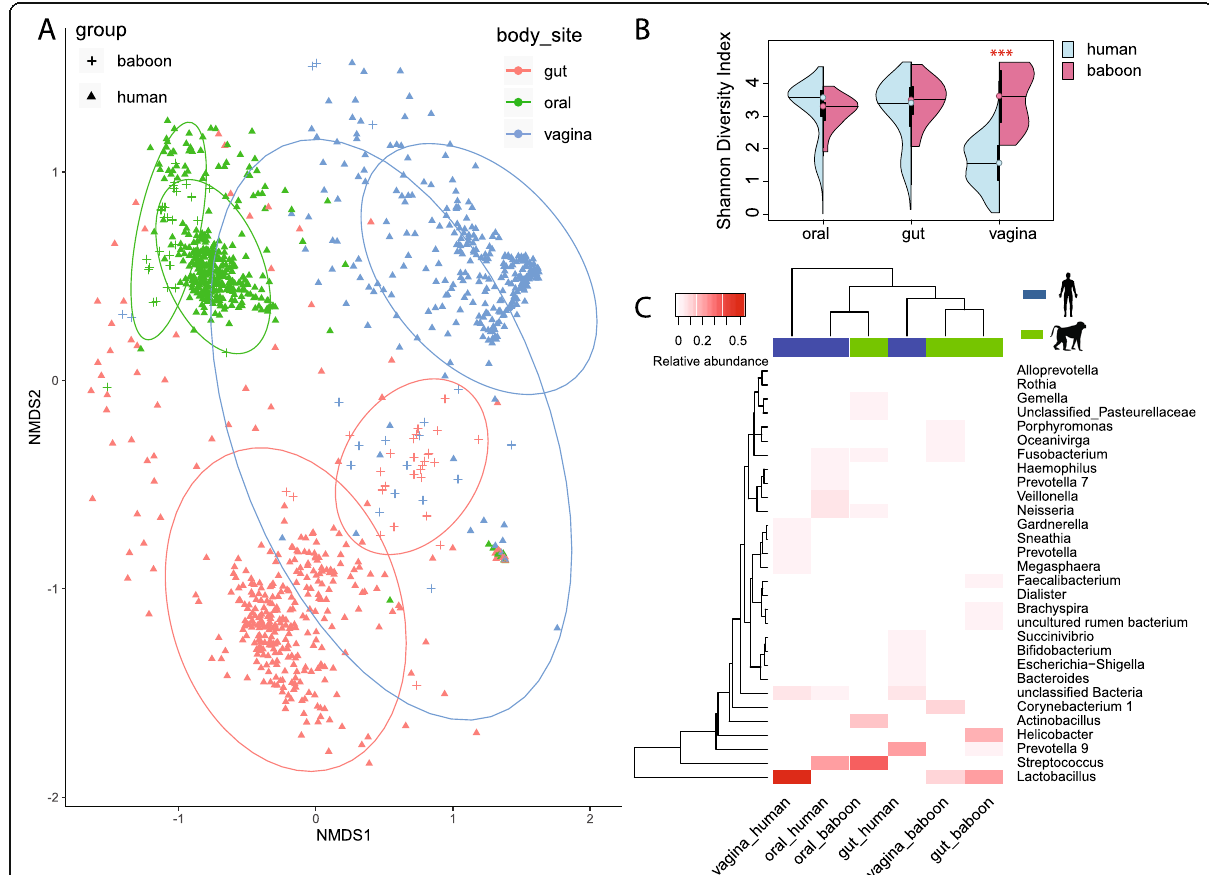
Fig. 3 Comparisons between the human and baboon microbiomes in the oral cavity, gut and vagina. a Non-metric multidimensional scaling (NMDS) based on a Bray-Curtis distance matrix of microbial communities from baboon and human oral, gut and vagina. The colored lines surrounding each sample type are covariance ellipsoids. b Microbial alpha diversity in the human and baboon gut, oral cavity and vagina, as measured using the Shannon index of ASV-level bacteria. c Heatmap showing the 30 most abundant bacterial genera in human and